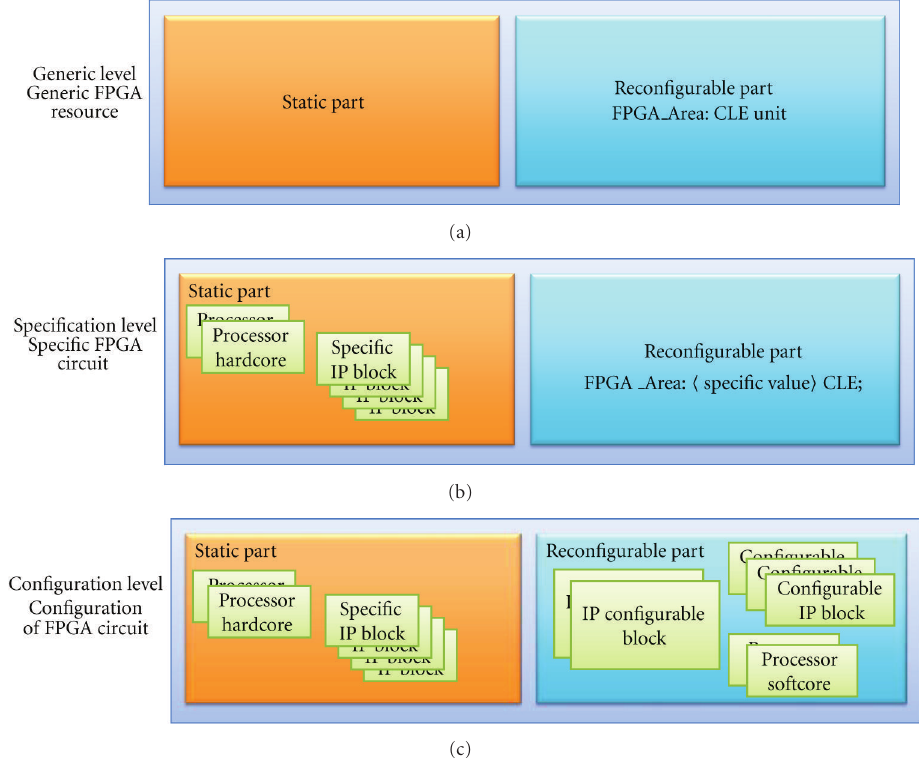
Figure 2: Multilayer and hierarchical approach to model FPGAs with the